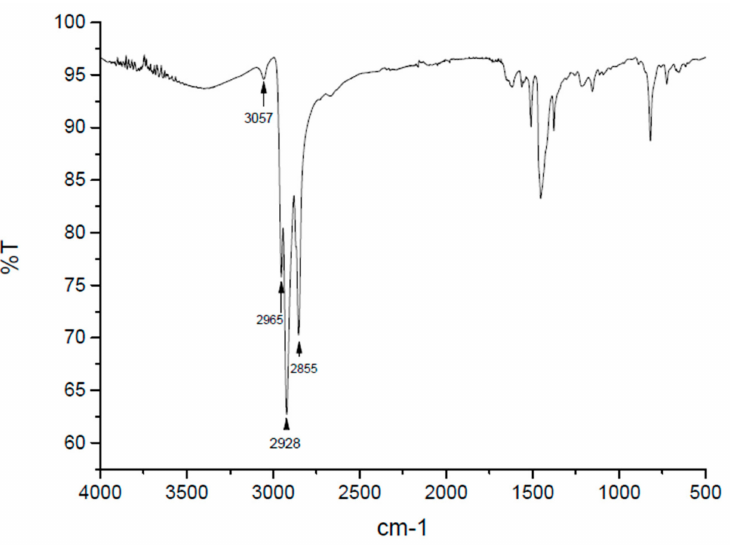
Figure A1. The 1 H NMR spectrum of the synthesised P3HT sample.